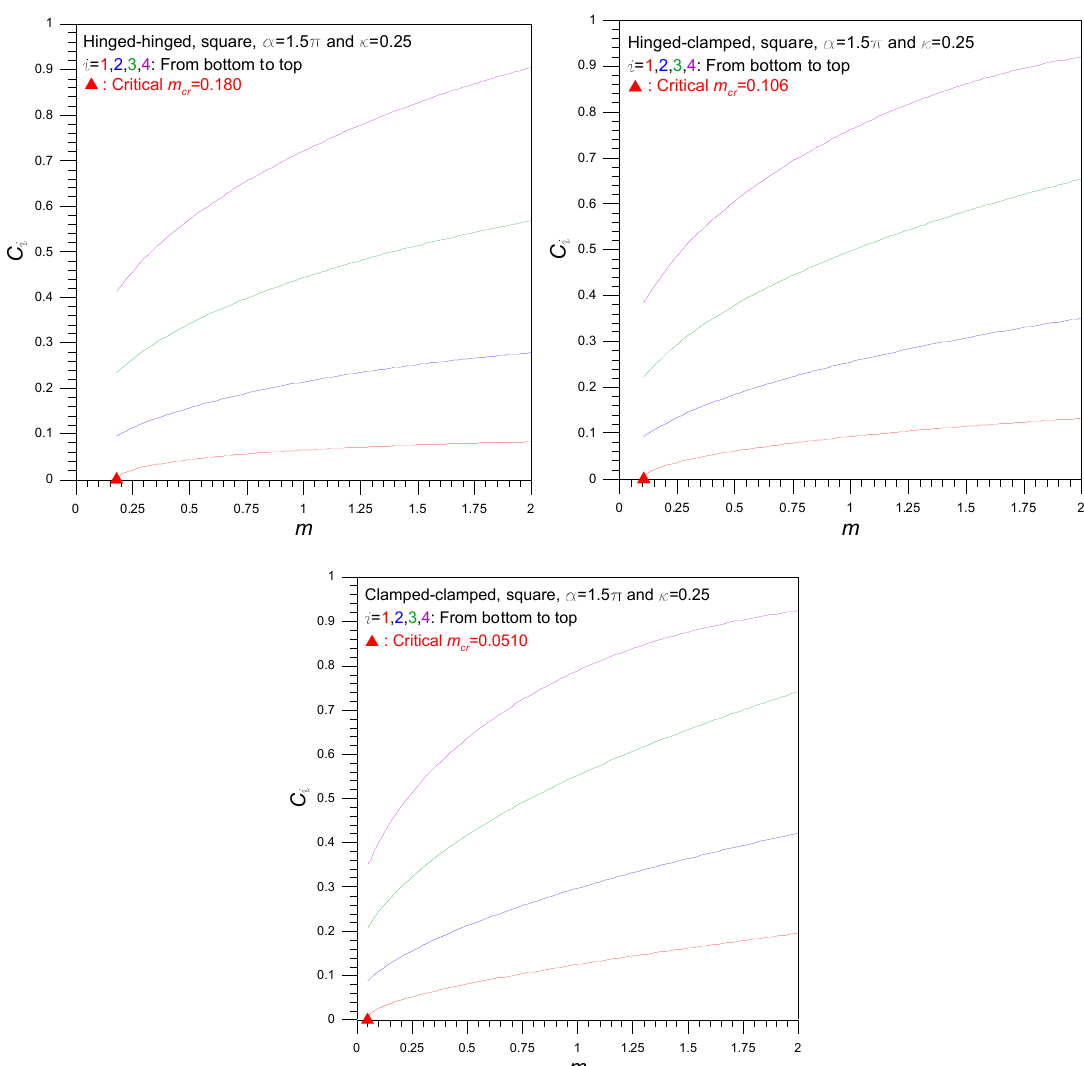
Figure 7. (cid:1829) (cid:3036) versus (cid:1865) curves. Figure 7. C i versus m